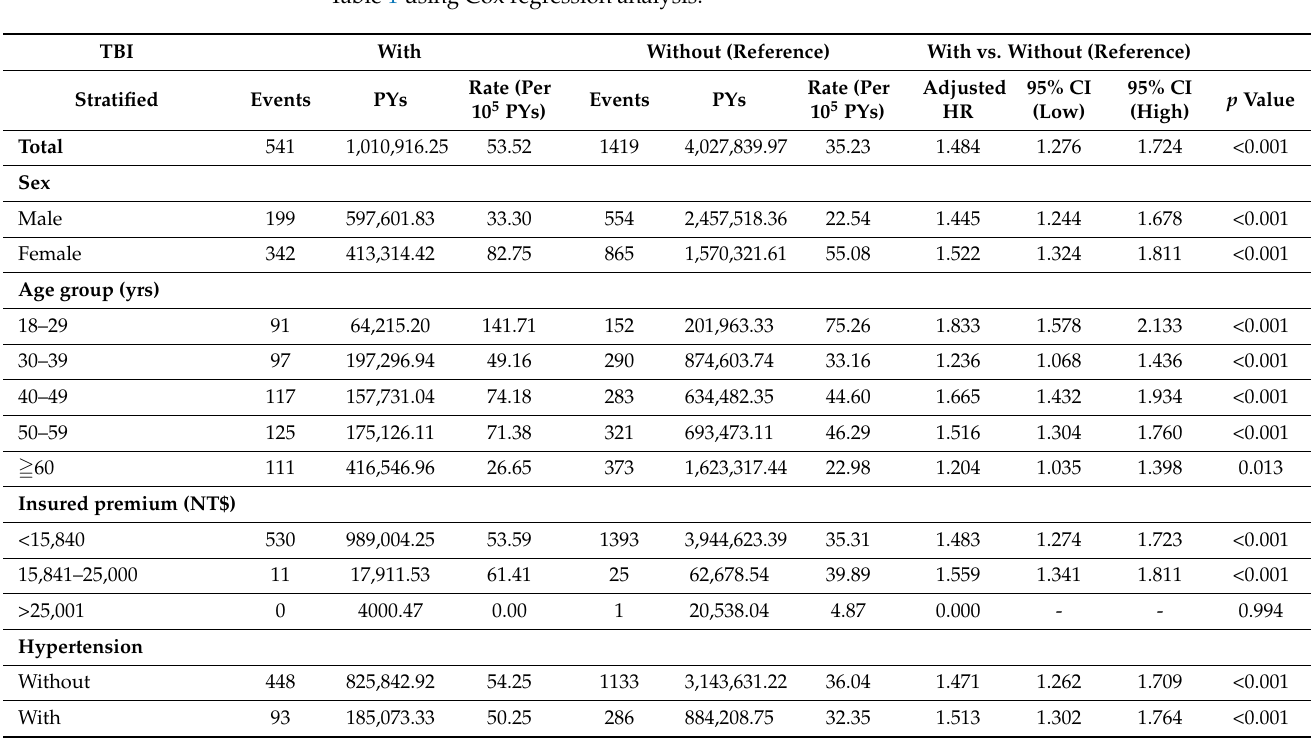
Table A4. Factors associated with the occurrence of migraine stratified by the variables listed in Table 1 using Cox regression